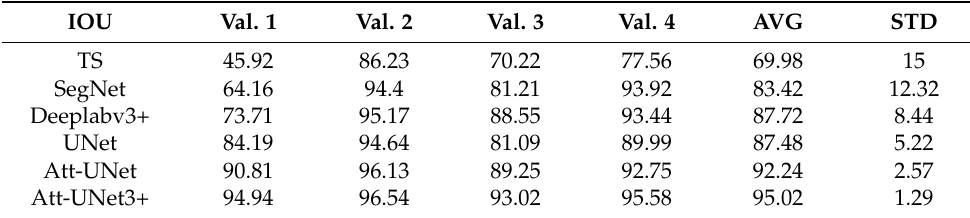
Table 3. IOU results of different methods in each validation sample (%).